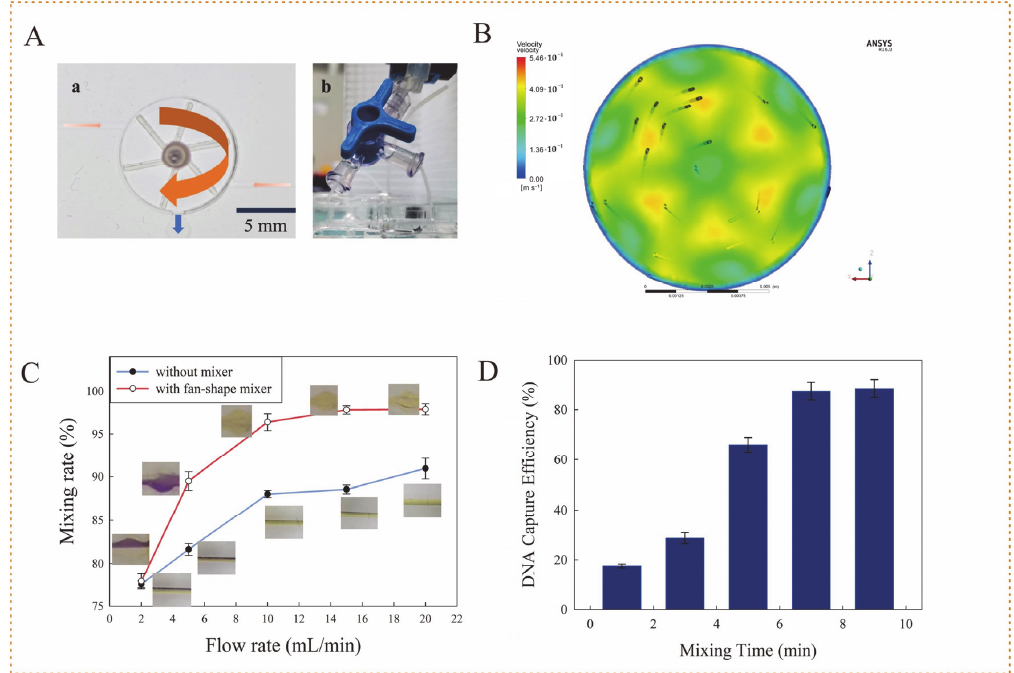
Figure 3. The mixing performance of the 3D-shaped mixer. ( A ) The structure of this 3D-printed fan-shaped mixer: (a) The photo of this mixer; (b) The three-way connector. ( B ) The simulation results of the fan-shaped mixer. ( C ) The mixing rate of the chambers with and without the mixer at different flow rates (N = 3). ( D ) The DNA capture efficiency for different mixing time at 10 mL/min (N = 3).